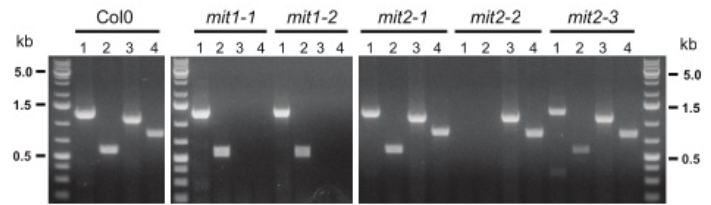
Figure 1. Identification of mit1 and mit2 individual mutants. ( A ) Exon-intron structure of MIT genes and T-DNA insertion sites. Exons are represented by boxes, and T-DNA insertion sites in the different mutant lines are shown (T-DNA inserts are not drawn to scale) (details in Supplementary Figures S2 and S3). Horizontal arrows indicate the positions of primers. ( B ) Genotyping of individual mit1 and mit2 plants showing they are homozygous mutants. Lanes 1: PCR of the wild type allele (primers 11 and 12 for MIT2 , 15 and 16 for MIT1 ); lanes 2: amplification of mutant alleles (primers LBb1.3 and 12 for mit2-1 , 11 and LB1sail for mit2-2 , 11 and LBb1.3 for mit2-3 , 15 and LBb1.3 for mit1-1 , and LBb1.3 and 16 for mit1-2 ). PCR reactions with DNA from wild type Col0 plants were performed with all seven primer pairs (lanes 1 and 5: primers for wild type MIT2 and MIT1 alleles; lanes 2 to 4: primers for mutant mit2-1 , mit2-2 , and mit2-3 alleles; lanes 6 and 7: primers for mutant mit1-1 and mit2-2 alleles). ( C ) MIT1 and MIT2 expression in individual WT, mit1 , and mit2 plants. cDNAs from homozygous mit1-1 , mit1-2 , mit2-1 , mit2-2 , mit2-3 mutants, and WT plants were amplified (40 cycles) with two primer pairs for each (position indicated in Figure 1A). MIT transcript: primers 17 and 18 (lanes 1) or primers 11 and 12 (lanes 2) for MIT2 , primers 13 and 14 (lanes 3) or primers 15 and 16 (lanes 4) for MIT1 . Size standards correspond to the GeneRuler 1kb Plus DNA ladder from Thermo